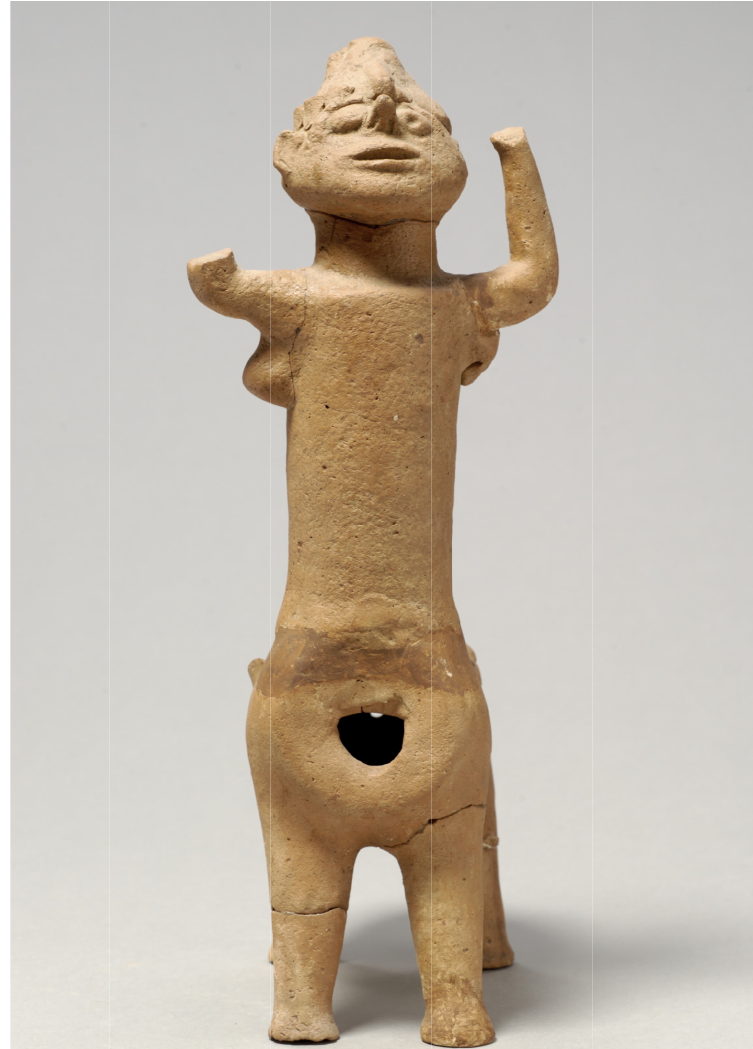
Figure 4. Terracotta ‘minotaur’ with uplifted arms, A.I. 1775, ©